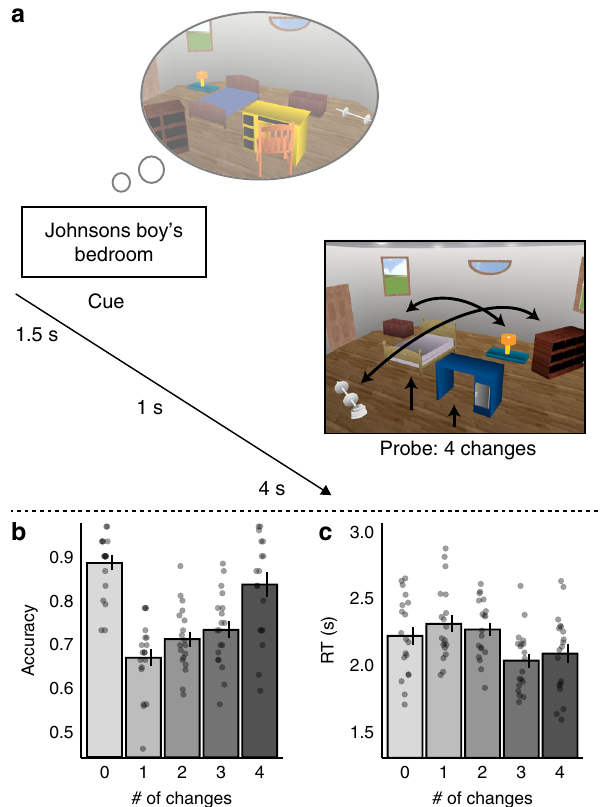
Fig. 1 Trial example and behavioral results. a Trial example: participants were presented with a cue probing them to retrieve a room image that they had extensively learned prior to the scan. After a short delay, they saw a probe image that included 0 – 4 changes relative to the learned image (four changes here), and indicated whether the seen image matched the learned image (see Methods). b Accuracy and c reaction times (RTs) in the match task. N = 19. Data are presented as mean values, error bars re fl ect + / − SEM. Source data are provided as a Source Data fi